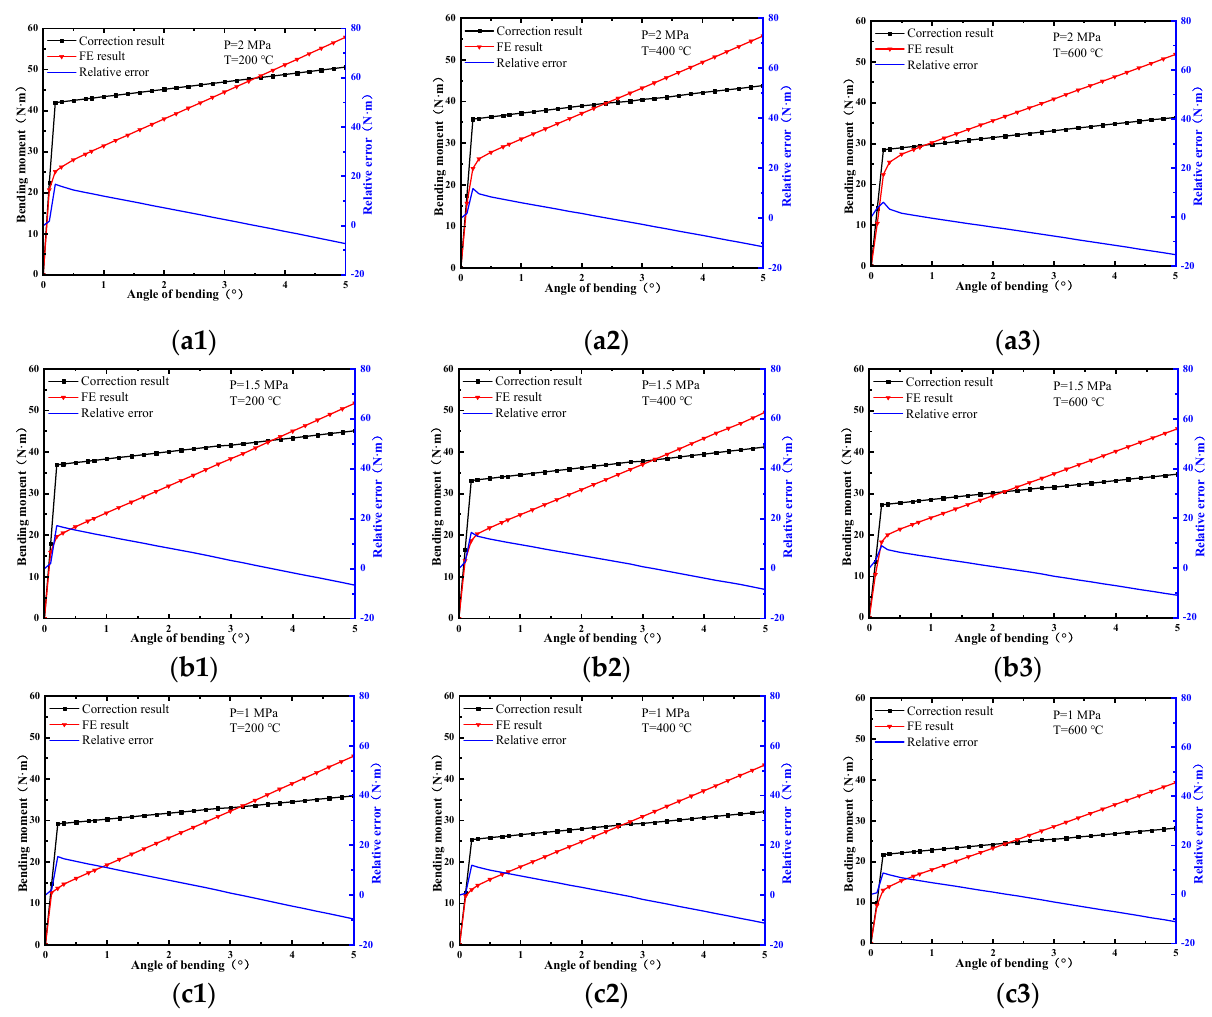
Figure 14. Corrected bending characteristics: ( a1 ) P = 2 MPa, T = 200 °C; ( a2 ) P = 2 MPa, T = 400 °C; ( a3 ) P = 2 MPa, T = 600 °C; ( b1 ) P = 1.5 MPa, T=200 °C; ( b2 ) P = 1.5 MPa, T = 400 °C; ( b3 ) P = 1.5 MPa, T = 600 °C; ( c1 ) P = 1 MPa, T = 200 °C; ( c2 ) P = 1 MPa, T = 400 °C; ( c3 ) P=1 MPa, T = 600 °C.